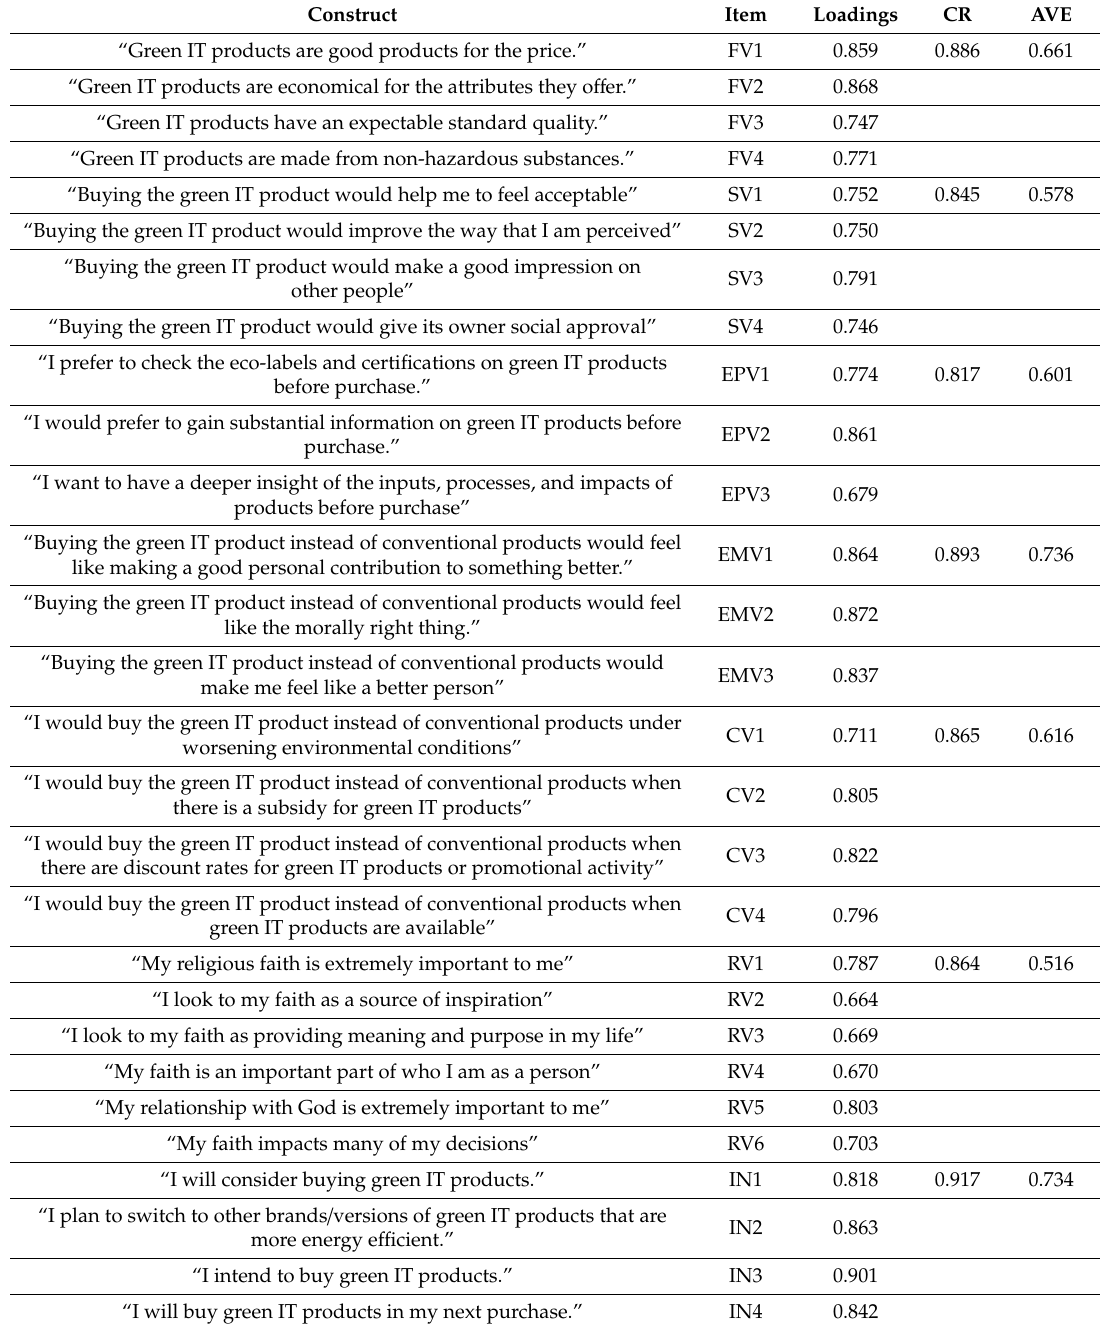
Table 3. Measurement Model